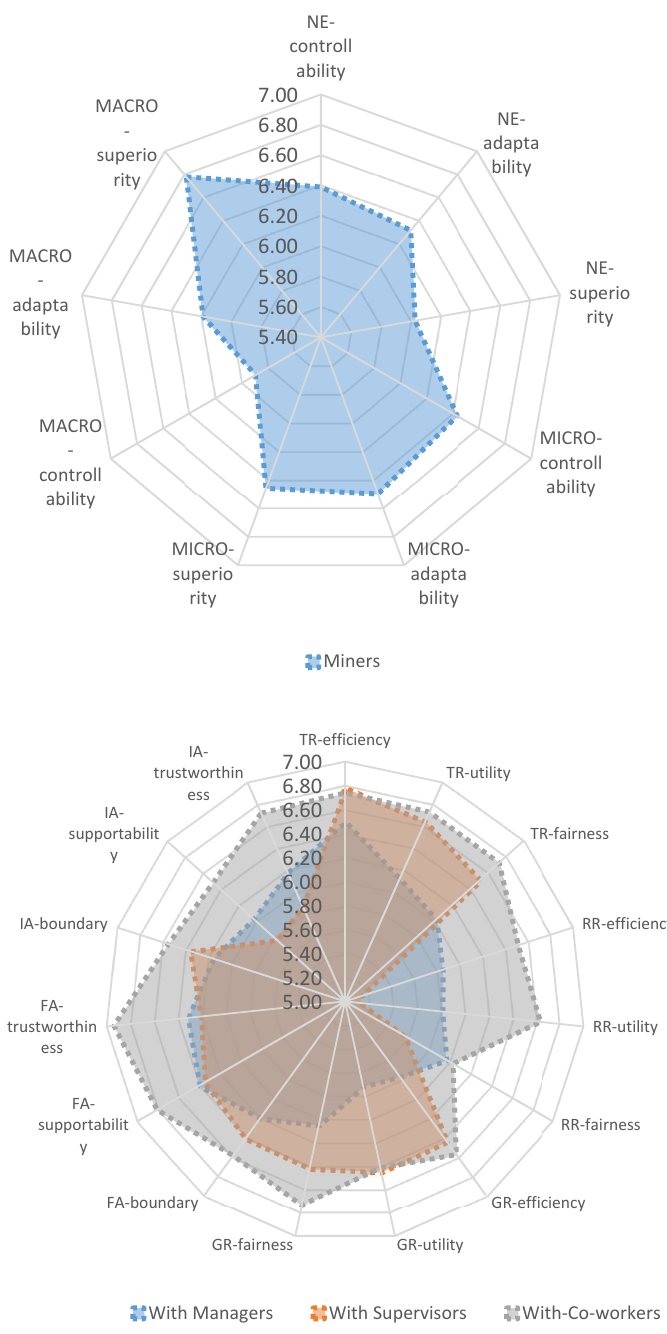
Figure 2. Spider graph of the total workers’ means for instrument items for the environment (macro, micro, natural environment), resource-based (task resources, relatedness resources, growth resources), and affect-based (formal affection, informal affection) interactions.